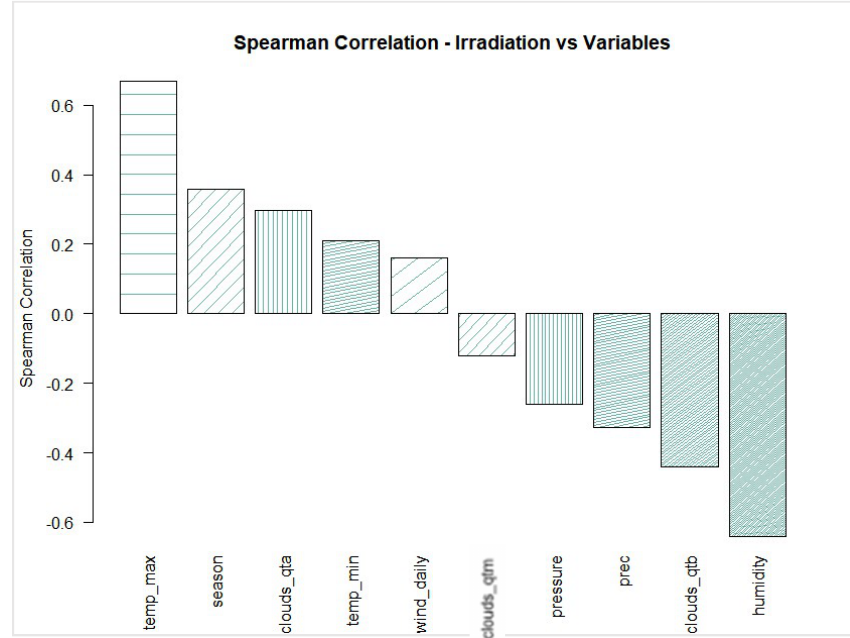
Figure 4. Spearman correlation between irradiation and meteorological parameters. Four different variable groups were defined based on the top positive and negative Table 3. Meteorological parameter grouping.